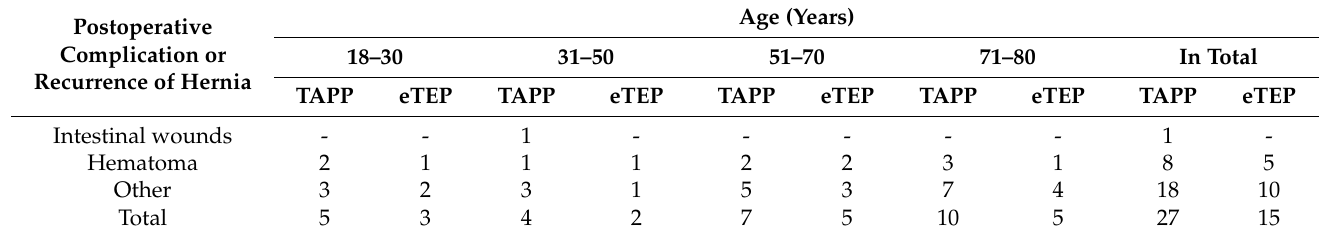
Table 4. Comparative characteristics of postoperative complications or recurrence of hernia.